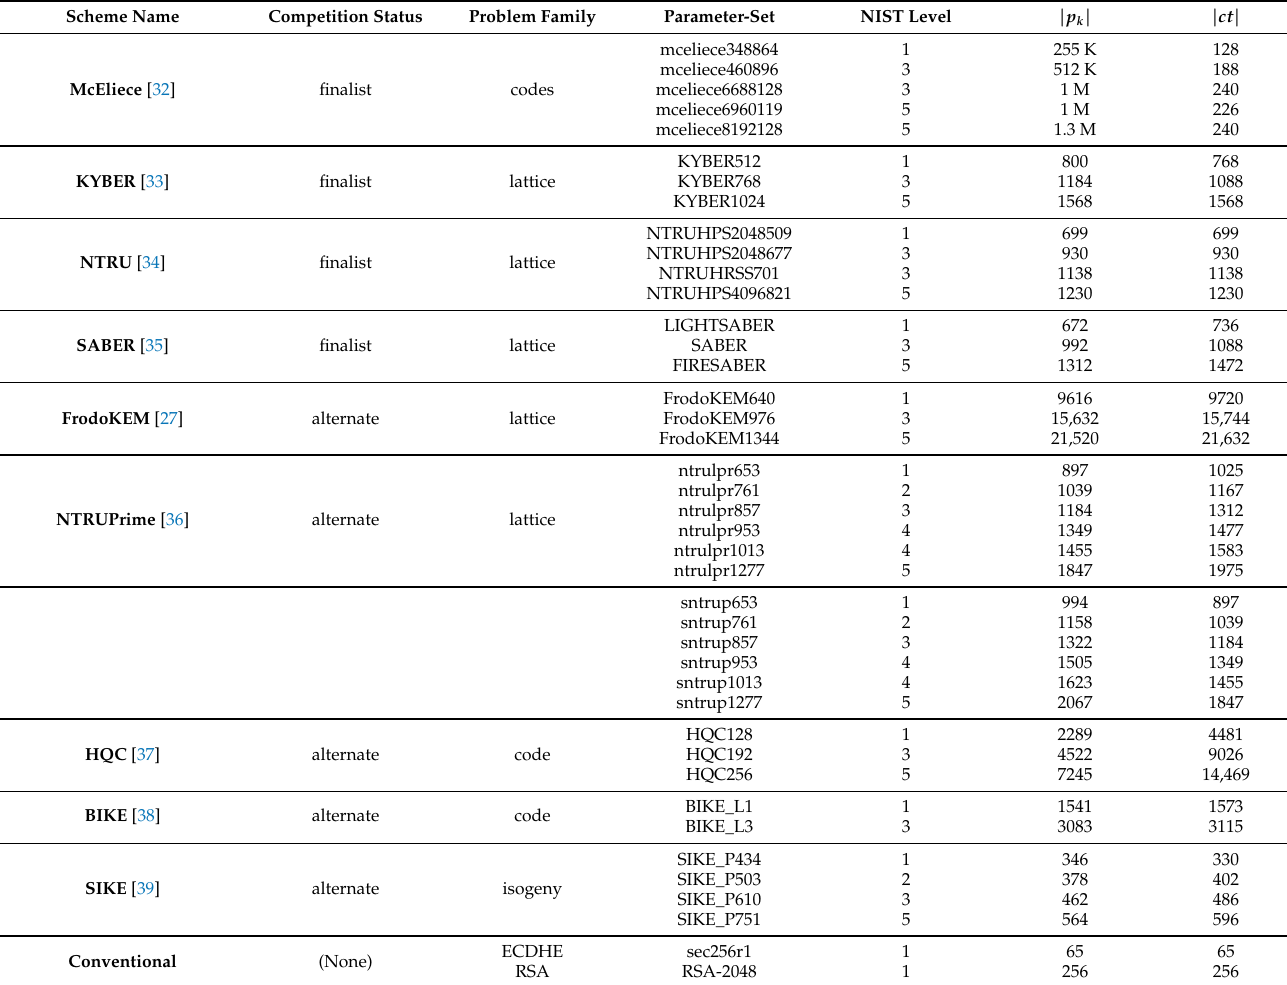
Table 3. US NIST Round 3 KEMs. The NIST Level shows the NIST security level according to Table 1; | p k | and | ct | denote the size of the public key and ciphertext in bytes. We also included the state-of-the-art key-exchange algorithms RSA and ECDHE for